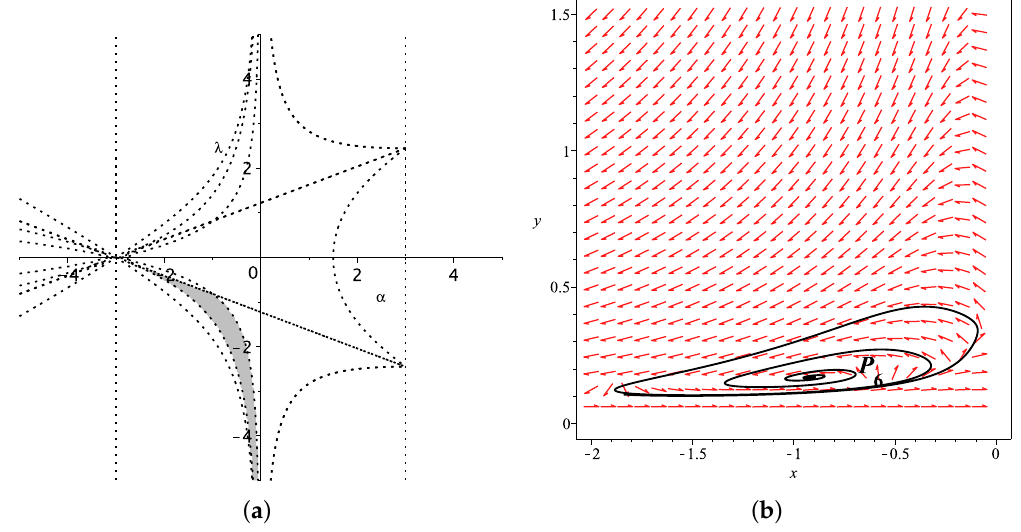
Figure 4. ( a ) The value range for parameters λ and α to make the critical point P 6 exist and stable, also constrained by other cosmological quantities, when x < 0. ( b ) The phase plane for λ = − 11 and α = − 0.02 around the attractor P 6 = ( − 0.915,0.171 ) when x <